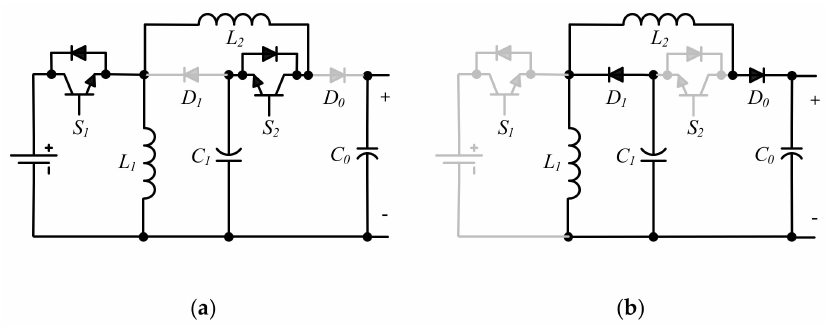
Figure 3. The mode of the main converter: ( a ) on mode; ( b ) o ff